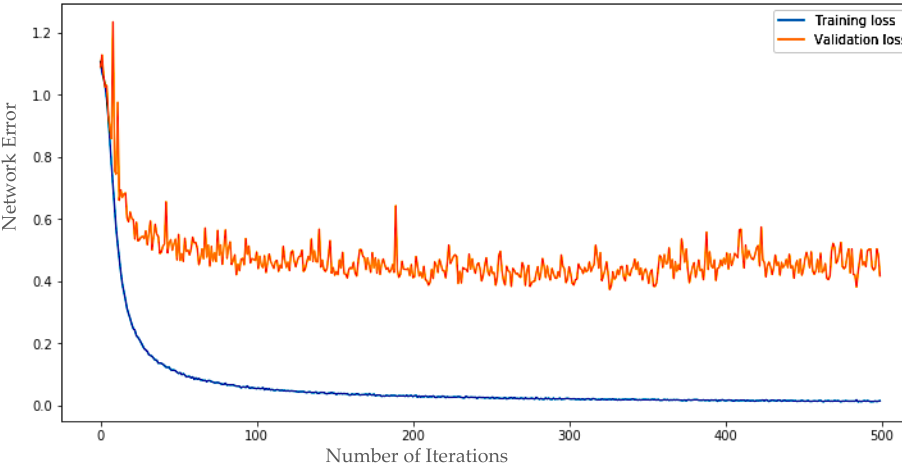
Figure 9. The proposed network error for three-class scenarios for F3 and C3 channels.